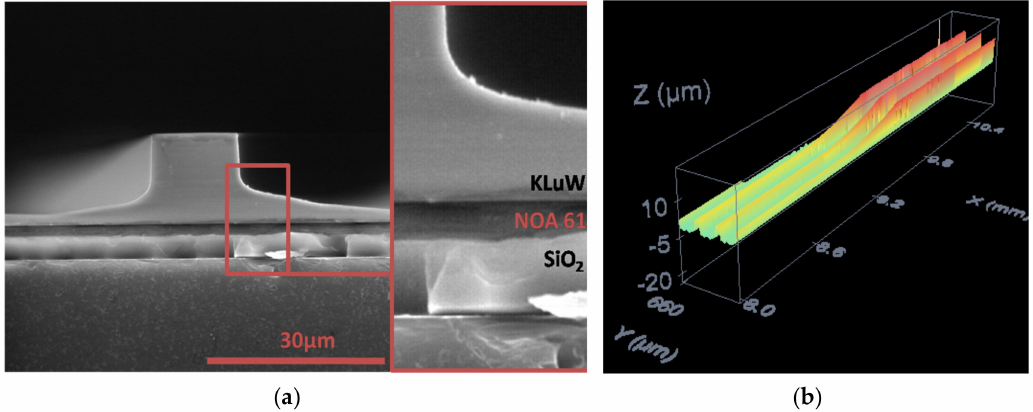
Figure 3. ( a ) Environmental scanning electron microscope (ESEM) image of the cross section of the waveguide platform. ( b ) Confocal microscope topography of tapered